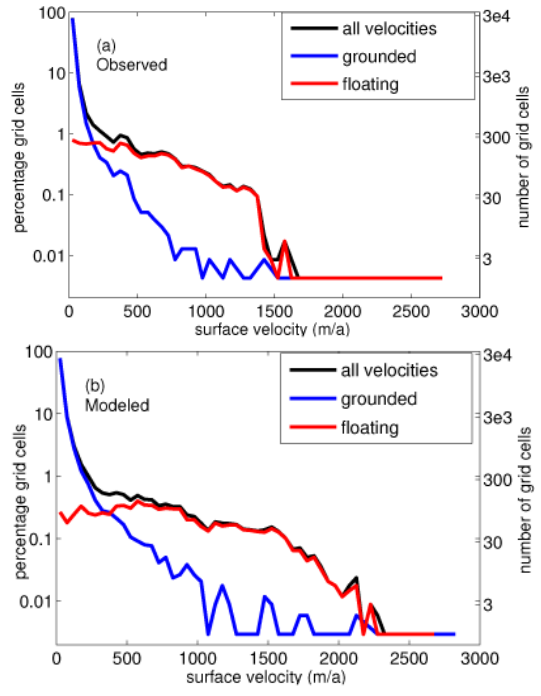
Fig. 15. Histogram of velocity distribution. (a) observed (b) modeled. Each of the 60 bins contains a velocity range of 1 v surface = 50ma − 1 .